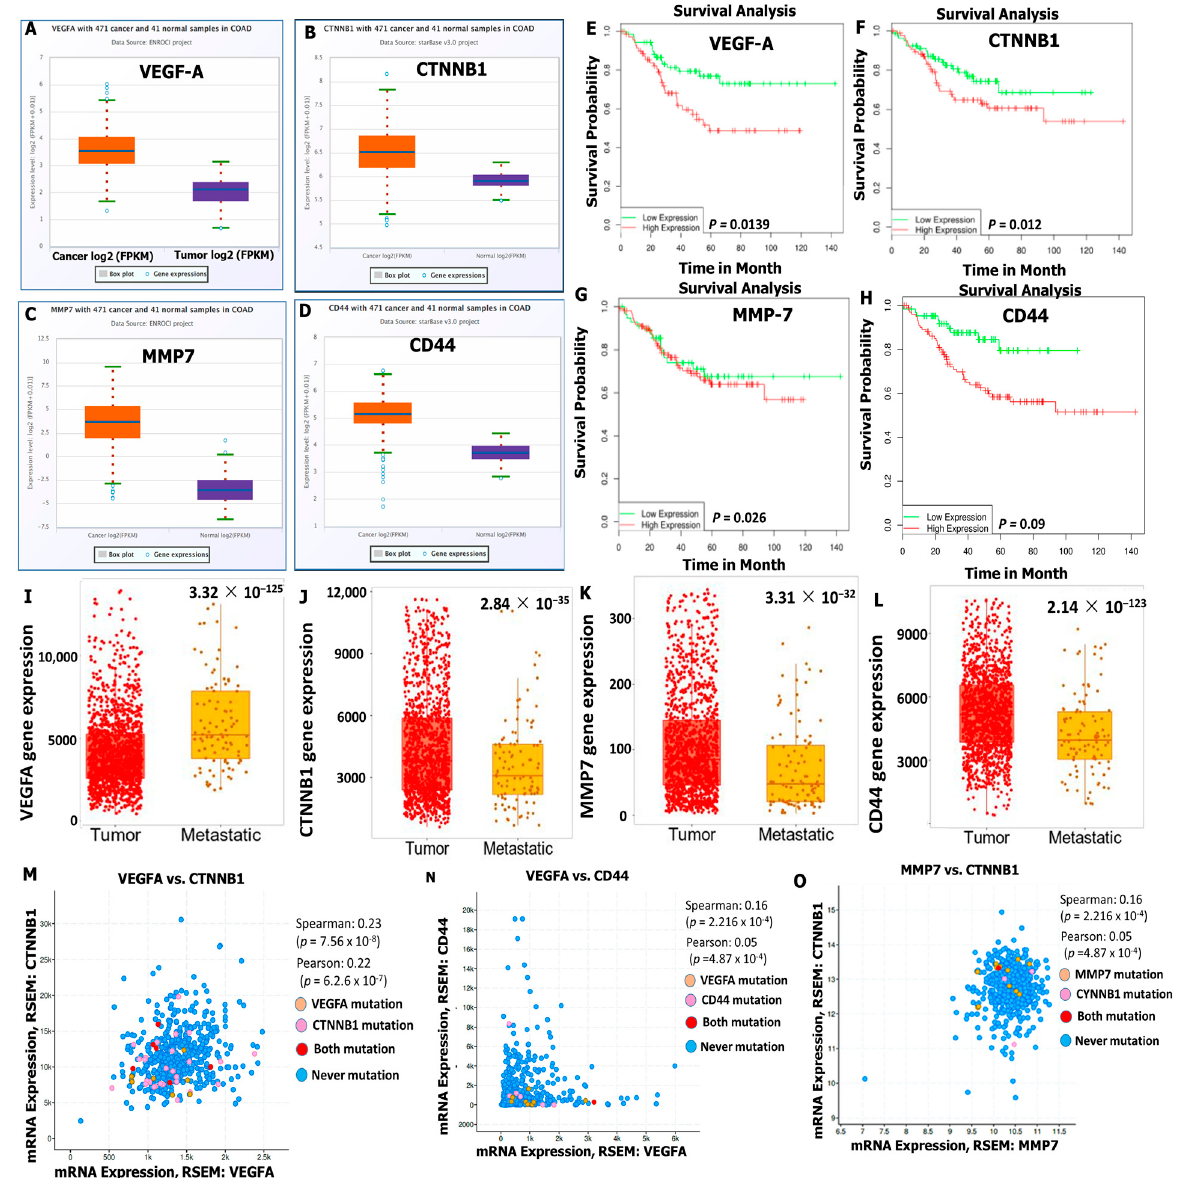
Figure 5. VEGFA/CTNNB1/MMP7/CD44 oncogenic signatures are overexpressed in CRC and associated with a poor prognosis. Vascular endothelial growth factor- α ( VEGFA) /beta catenin ( CTNNB1 )/matrix metalloproteinase ( MMP) ‐ 7 /cluster of differentiation 44 ( CD44 ) oncogenic mRNA levels were overexpressed in colorectal cancer (CRC) tumor cohorts compared to normal samples with significant p values ( A – H ). Elevated mRNA levels of VEGFA/CTNNB1/MMP7/CD44 were found to be associated with shorter survival times in CRC patients using the Wilcoxon test. ( I – L ) Upregulated gene expression of VEGFA , CTNNB1 , MMP7 , and CD44 genes promoted primary tumor and cancer metastasis in CRC tissues. ( M – O ) The combination of all the four genes showed positive correlations in the range of r = 0.16~0.27 of VEGFA with CTNNB1 , VEGFA with CD44 , and CTNNB1 with MMP7 in CRC patients. Pearson correlation coefficients of p < 0.05 were considered statistically significant.